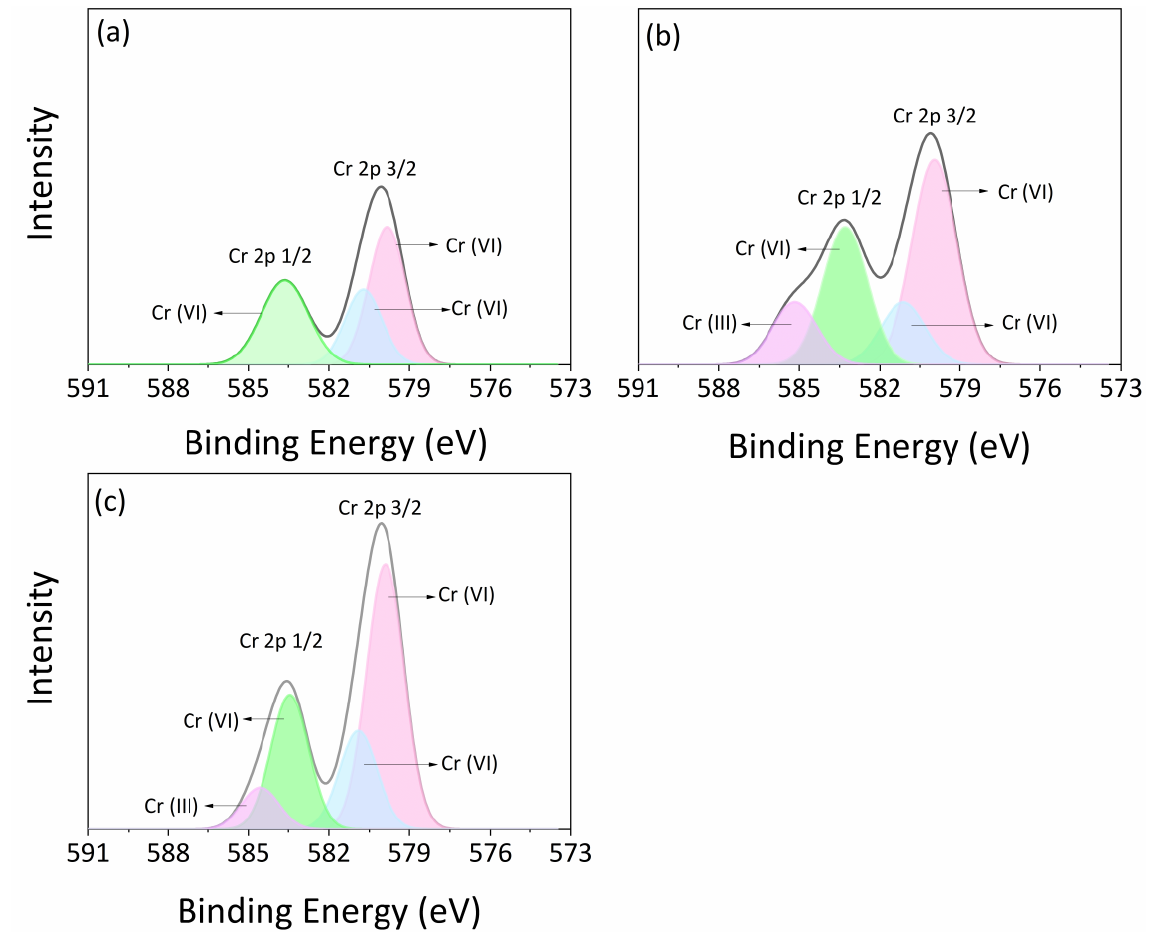
Figure 4. High-resolution XPS Cr 2p spectra of ( a ) struvite, ( b ) humic acid, and ( c ) struvite–humic acid composite after Cr (VI) adsorption.